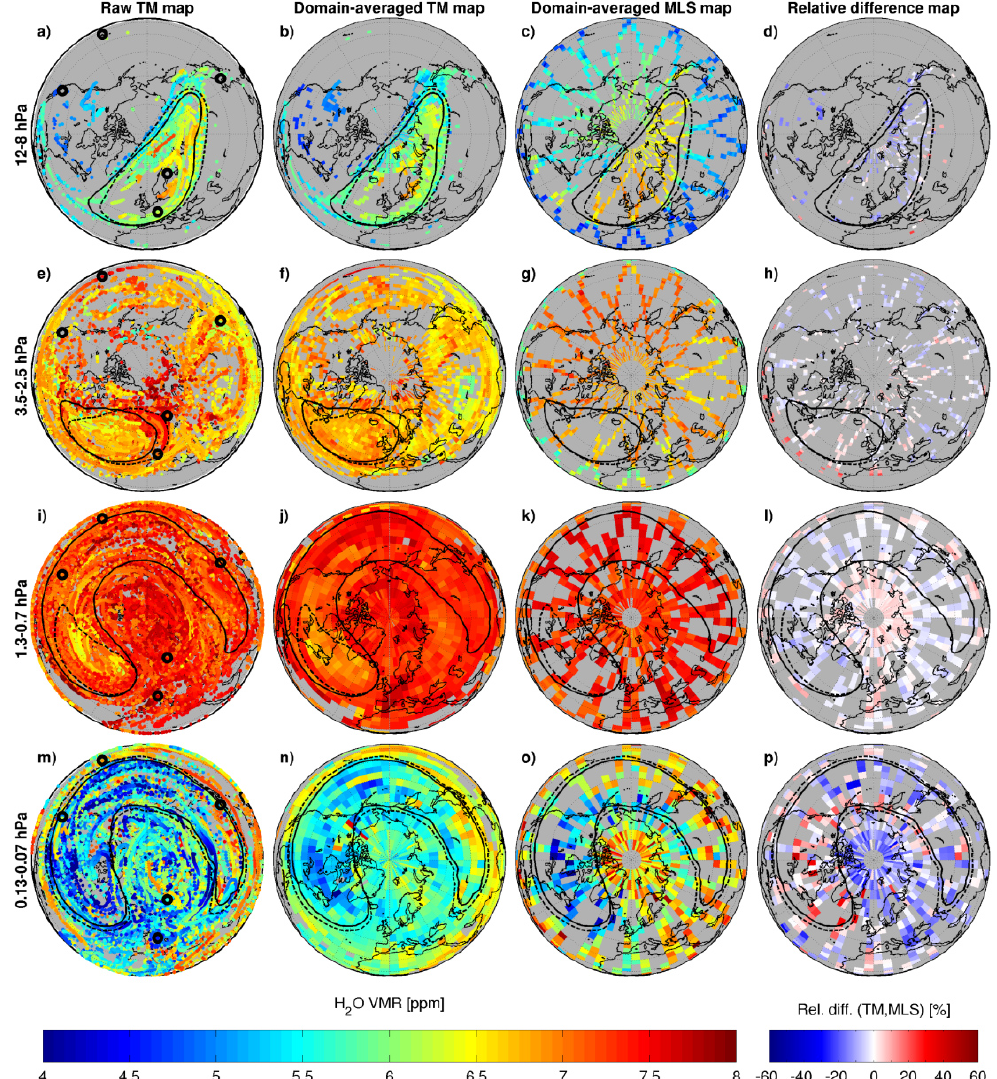
Figure 7. Case D: same as Fig. 3, except for 17 January 2012, 12:00UTC close to the maximum temperature increase at 10 hPa during a major SSW in the Northern